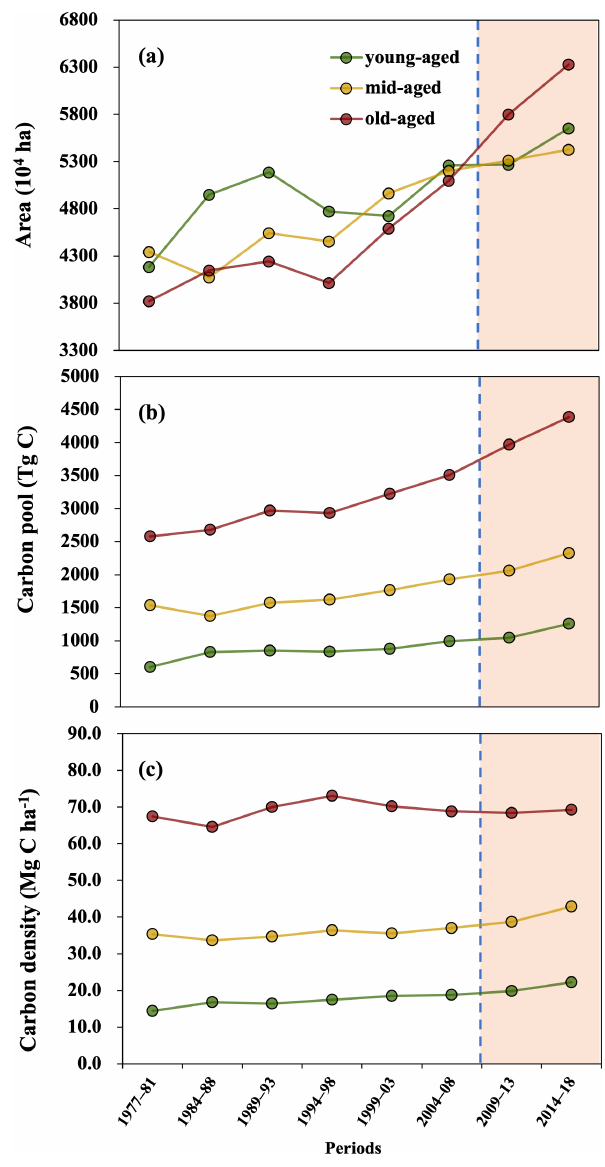
Figure 2. Changes in area (a) , C pool (b) , and C density (c) of forest for each age group from 1977 to 2018. The pink box highlights the latest results from the most recent 10